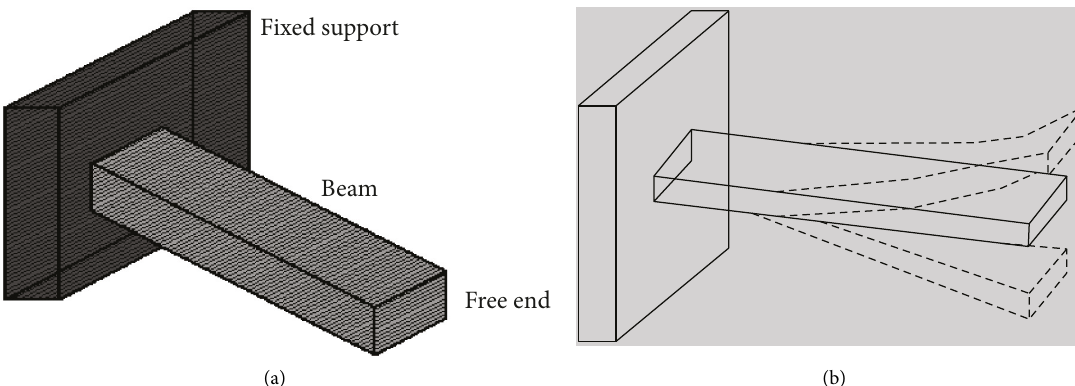
Figure 10: (a) Fixed cantilever beam. (b) Beam subjected to vibration.